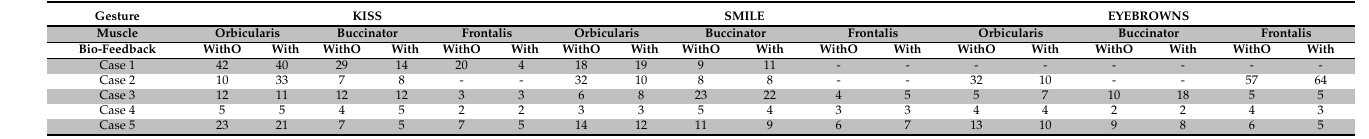
Table 2. Maximum electromyographic data (millivolts) in patients with facial